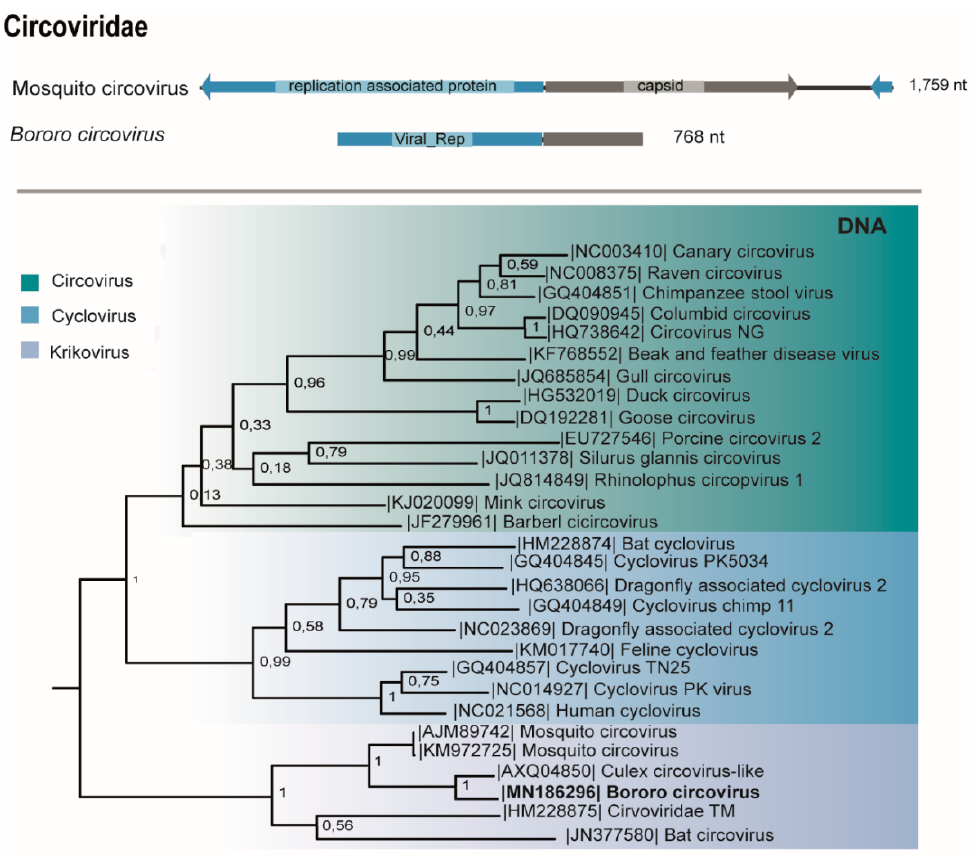
Figure 6. Genome map and the maximum likelihood phylogenetic tree of Bororo circovirus viral replication associated protein and other members of the Circoviridae family.